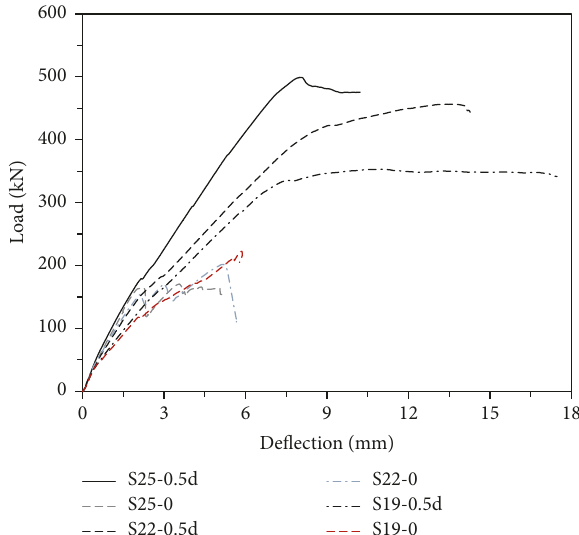
Figure 8: Load-deflection curves of shear test specimens.